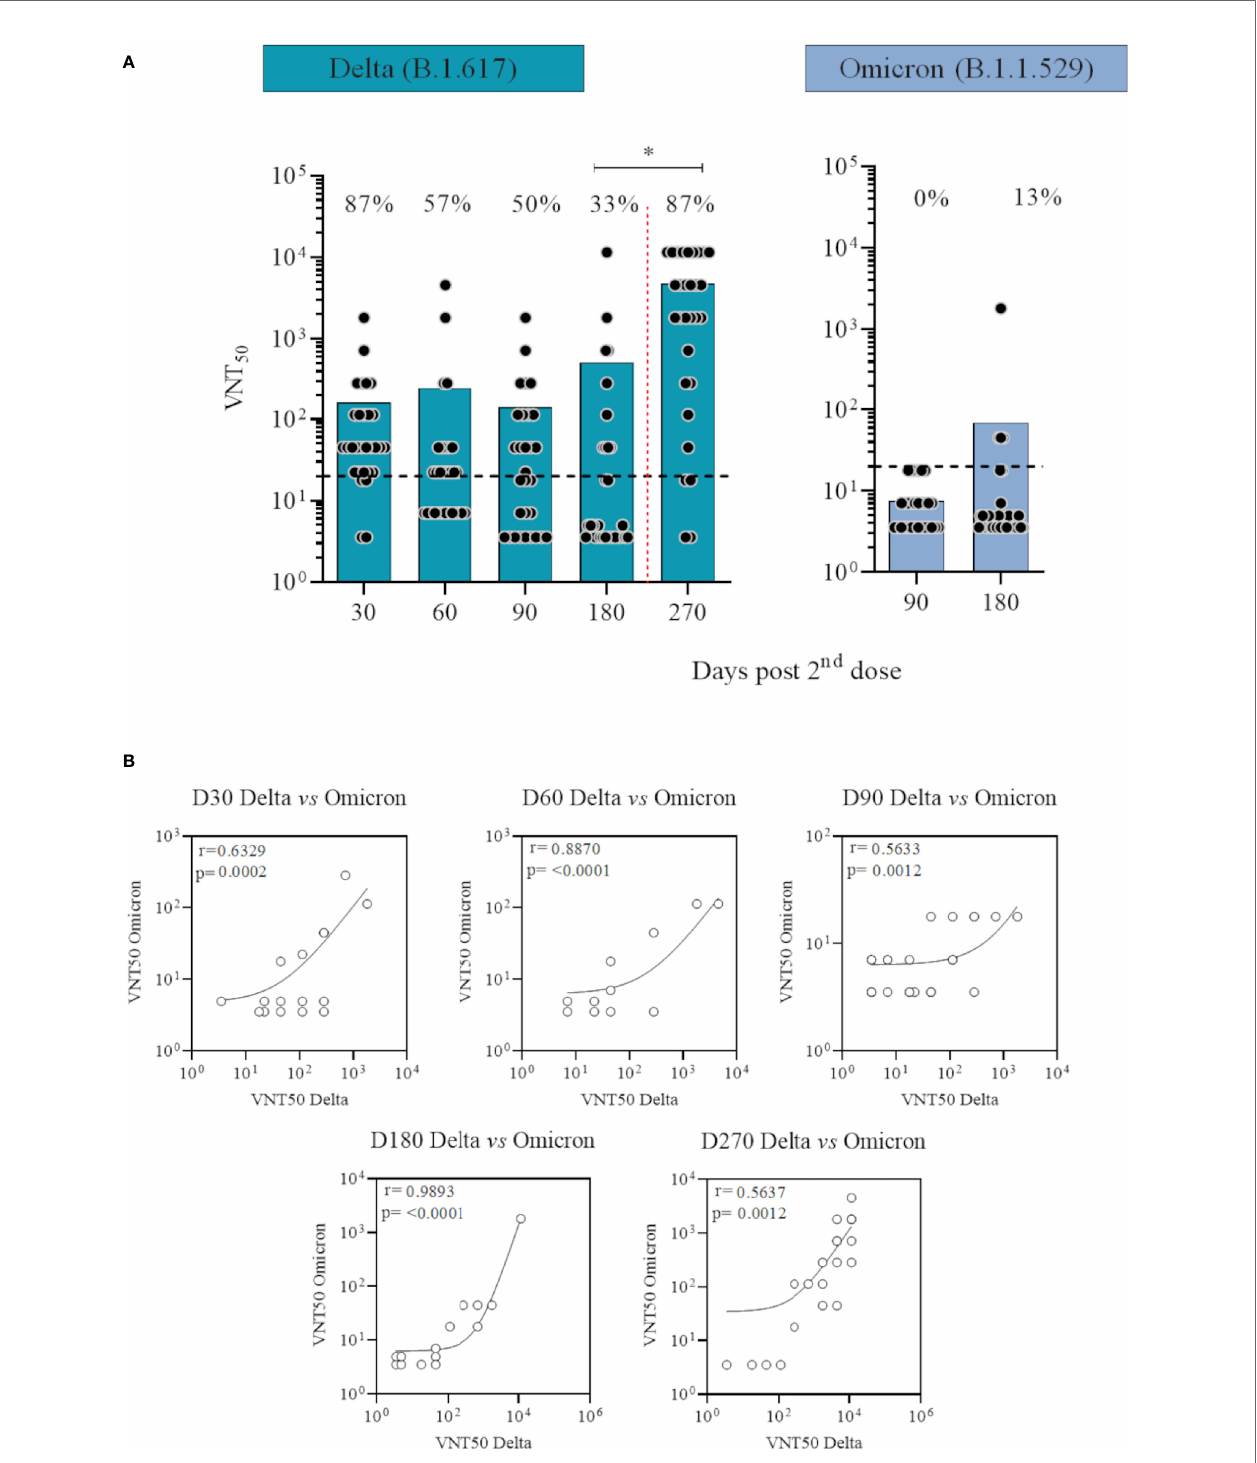
FIGURE 3 | Neutralising antibody levels against Delta (B.1.617) and Omicron (B.1.1.529) SARS-CoV-2 variants over time in participants vaccinated with CoronaVac two- dose regimen plus BNT162b2 booster without previous COVID-19. (A) Logged values from individual specimens are presented here grouped into number of days after second dose. Average of VNT50 (neutralising titers capable to inhibit 50% of SARS-CoV-2 cytopathic effect) values are represented by bars. A cut off at 20 (black dotted line) is shown. Red dotted lines represent booster dose timepoint. ANOVA statistical differences are presented by letters for comparisons over timepoints for the same variant. (B) Correlation between neutralising antibodies titers against Delta and Omicron variants over time. Spearman rho and p values are